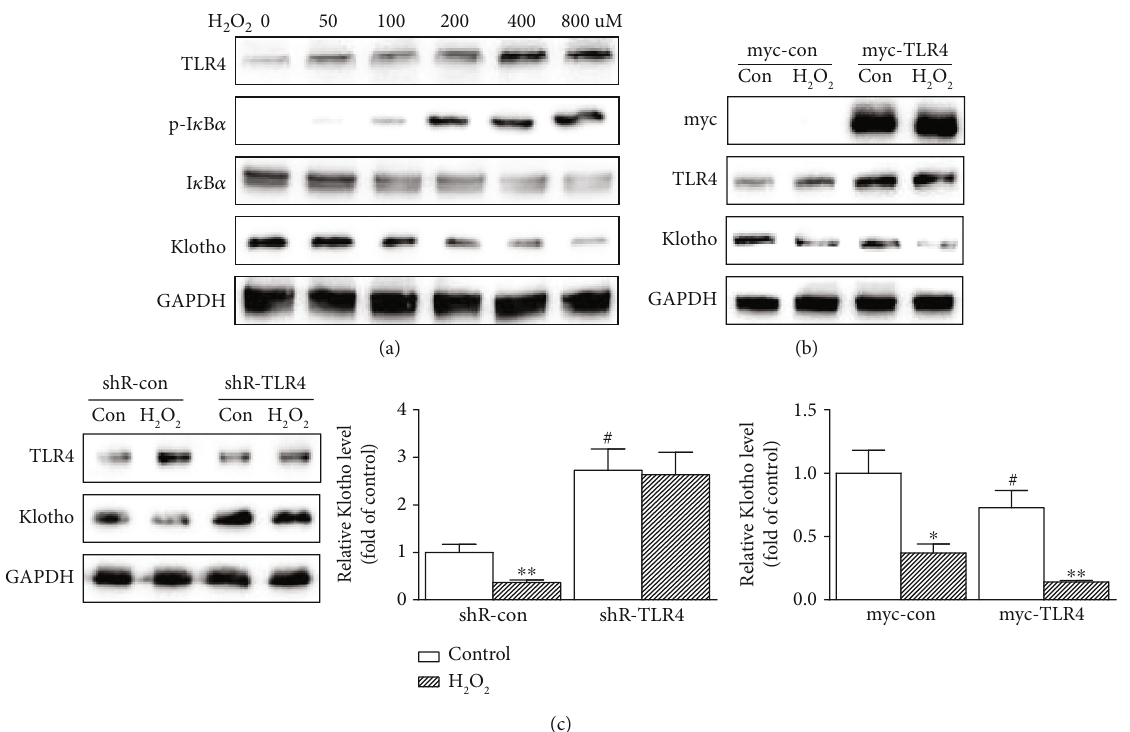
Figure 3: Regulation of Klotho by TLR4-NF- κ B signaling in NP cells. (a) NP cells were treated with increasing amounts of H 200, 400, and 800 μ M) for 12h, and then TLR4, p-I κ B α , I κ B α , and Klotho protein levels were assayed by Western blotting. (b) NP cells were transfected with control or a plasmid expressing myc-tagged TLR4 then treated with H tagged TLR4 was veri fi ed with an anti-myc antibody. TLR4 and Klotho were assayed by Western blotting. Bar graph on right: quanti fi cations of Figure 3(b). (c) NP cells were transfected with a control or a shRNA-TLR4 plasmid then treated with H for 12 h. Cell lysates were tested for TLR4 and Klotho expressions by Western blotting. Bar graph on right: quanti fi cation of Figure 3(c). GAPDH served as an internal control. The results were presented as mean ± SD of three independently performed experiments. ∗ P < 0 : 05 , ∗∗ P < 0 : 01 vs. control. # P < 0 : 05 vs. shR-con or